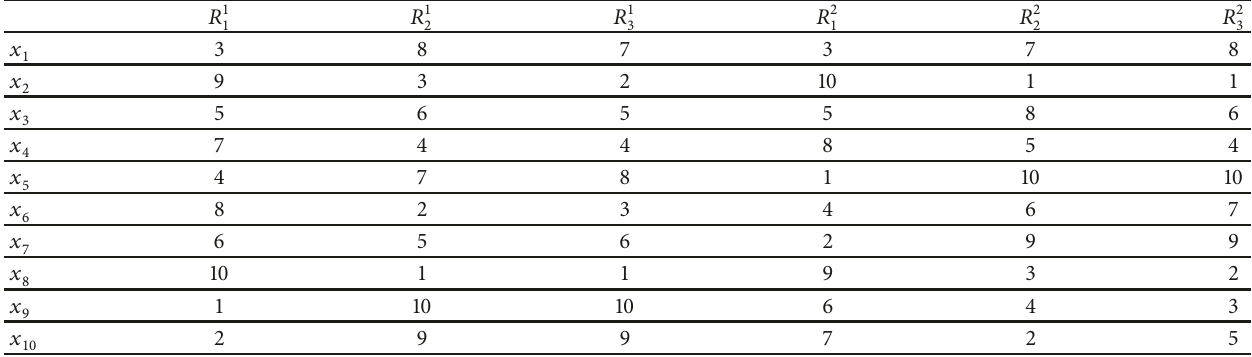
Table 9: The ranking of the probability of net advantage, the distance from the ideal solutions, and the utility of the dimensions of ability and reputation.